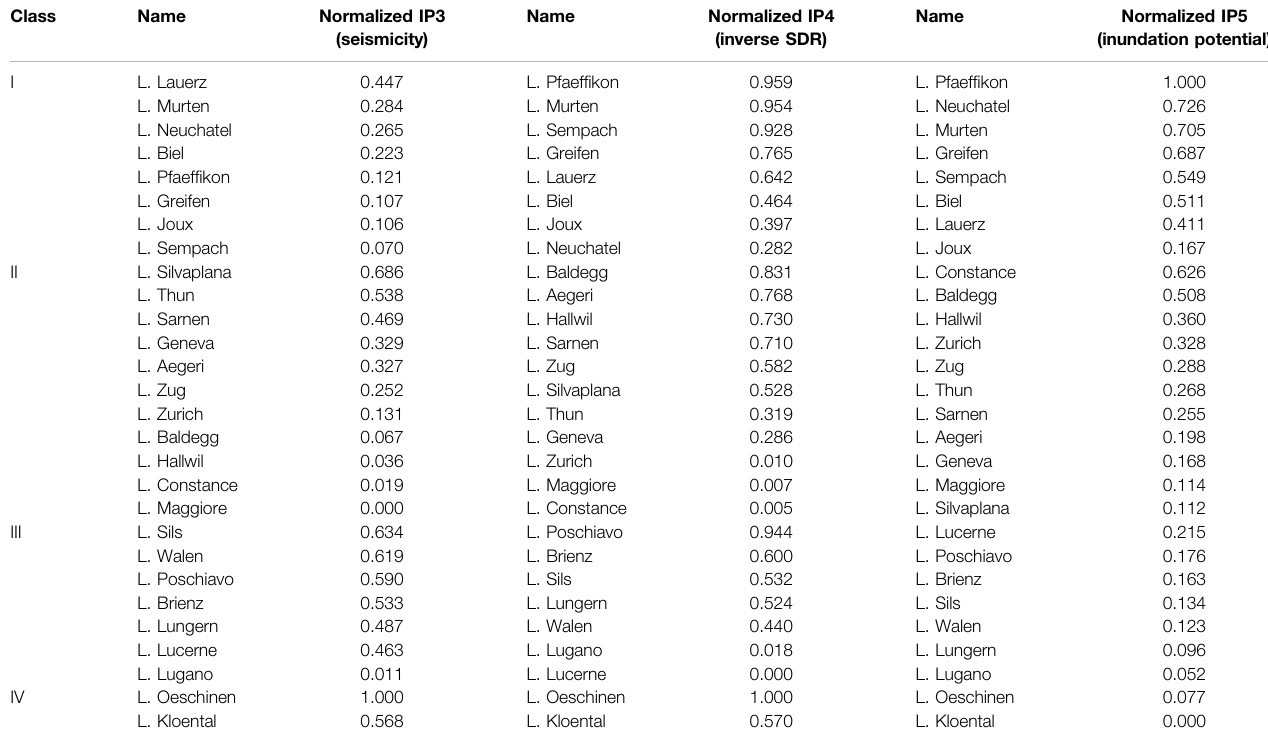
TABLE 4 | Prioritization according to IP3 (seismicity, left), IP4 (inverse SDR, middle), and IP5 (inundation potential, right), grouped by main tsunami source classes. Class